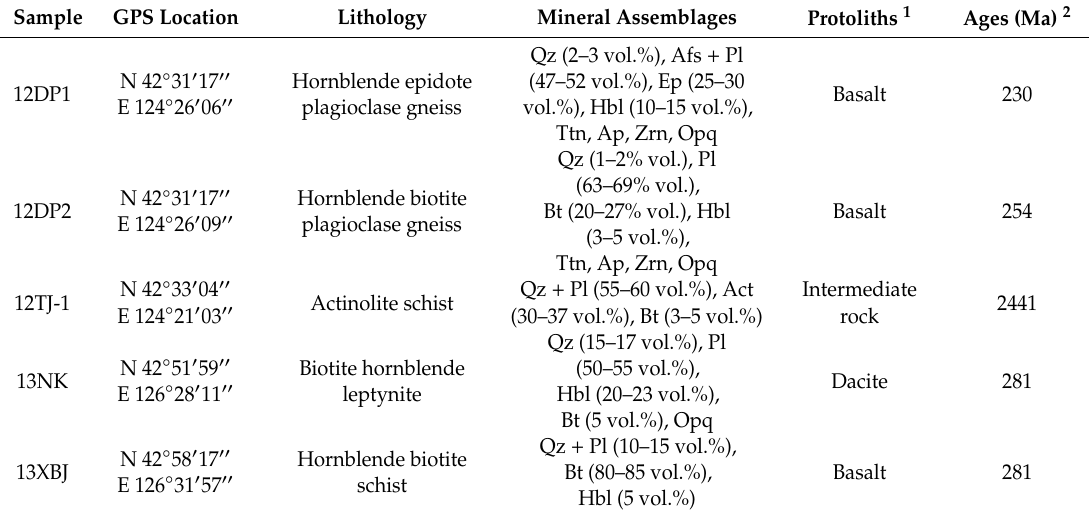
Table 1. Summary of the sample locality, lithology, mineral assemblages, and protoliths